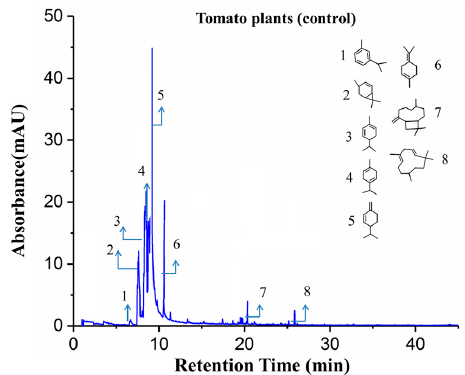
Figure 8. The GC-MS spectra of the VOCs released from healthy tomato plant (control).